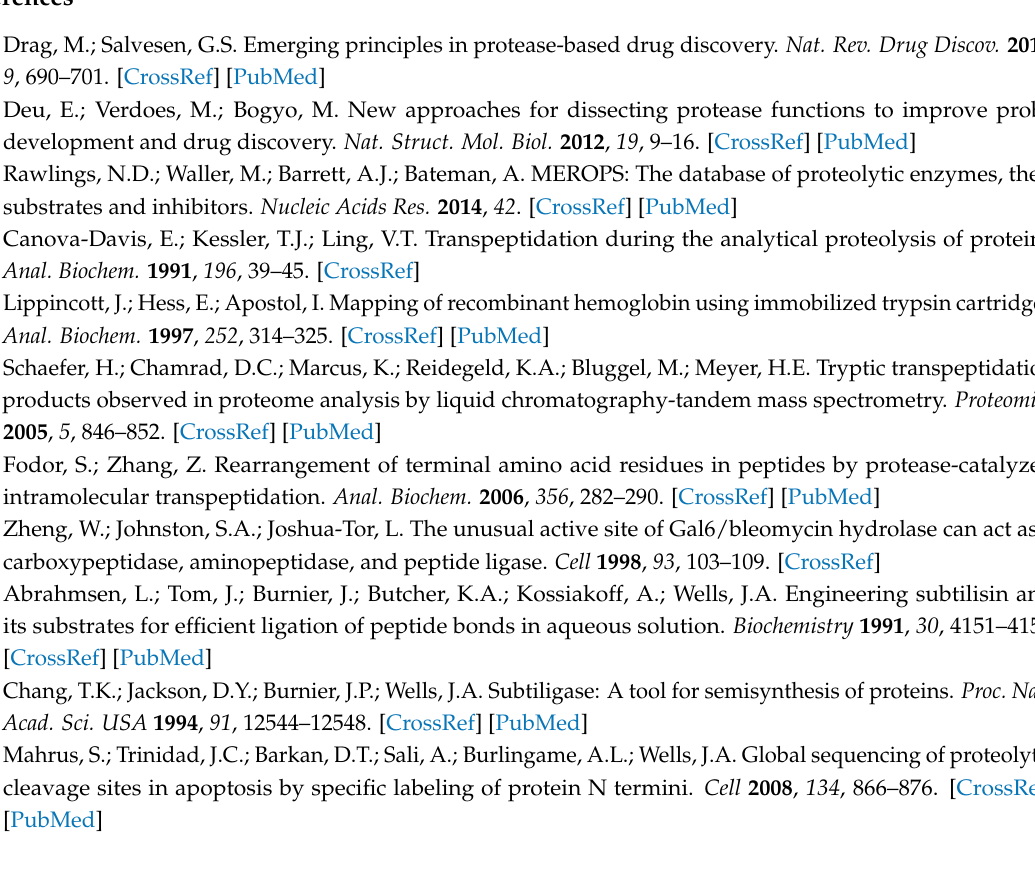
Supplementary Materials: The following are available online. Figure S1: MALDI spectra of the control experiments in which nucleophile, enzyme, or both nucleophile and enzyme were absent, Figure S2: Microscopic images of beads after on-bead reaction, Figure S3: MALDI spectra of peptides that were cleaved from blue beads, Figure S4: Chemical structures of probes used in Figure 5, Figure S5: The full time-course data for Figure 5B, Figure S6: MALDI spectra of the trypsin-treated addition products, and Figure S7: SDS-PAGE of the degradation of two misfolded